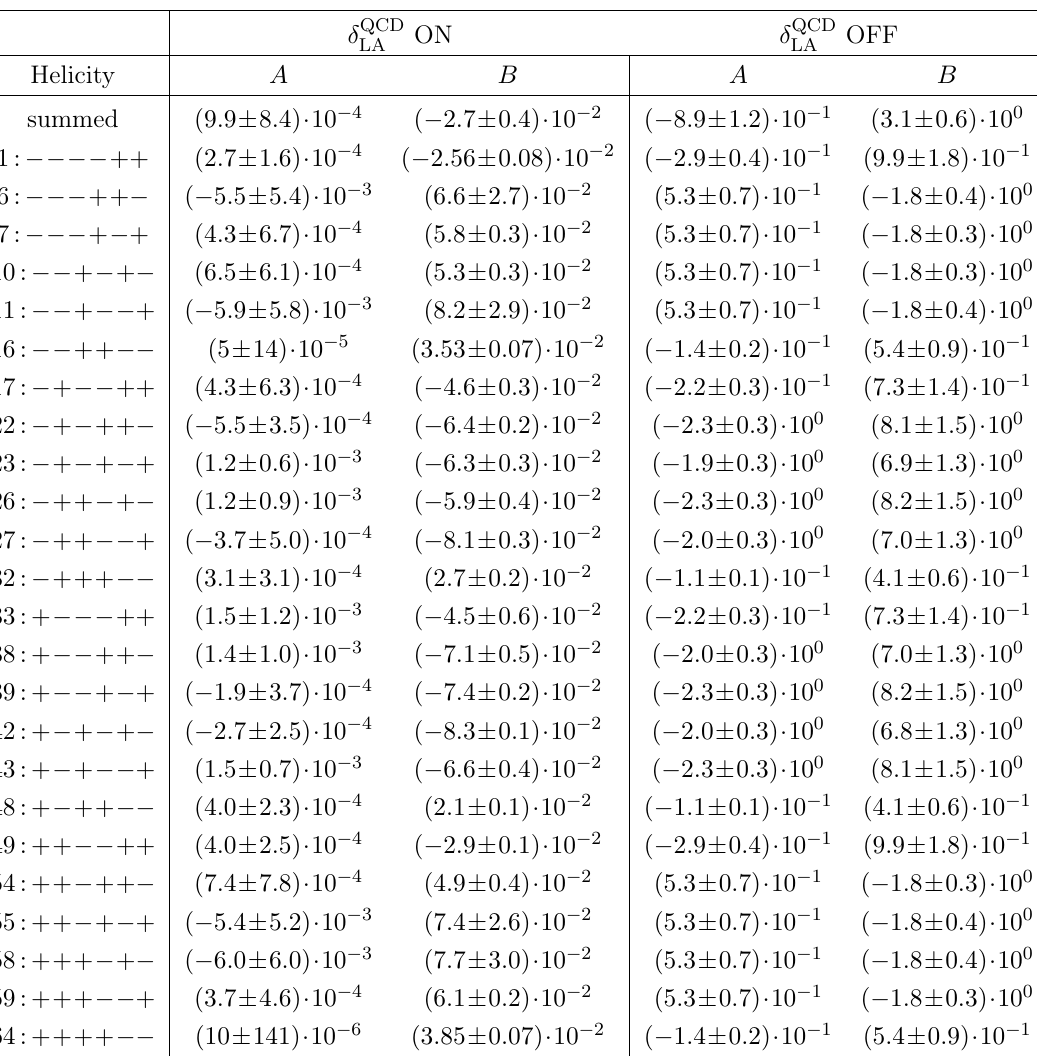
Table 2 . Result of the fit of the quantity (Virt-SDK)/LO using the method of least squares and the function (6.2) for the representative process gg ! t (cid:22) tt (cid:22) t . The case including(excluding) the (cid:14) QCD contribution corresponds to the quantities shown in the second(third) inset of the lower-central plot of figure